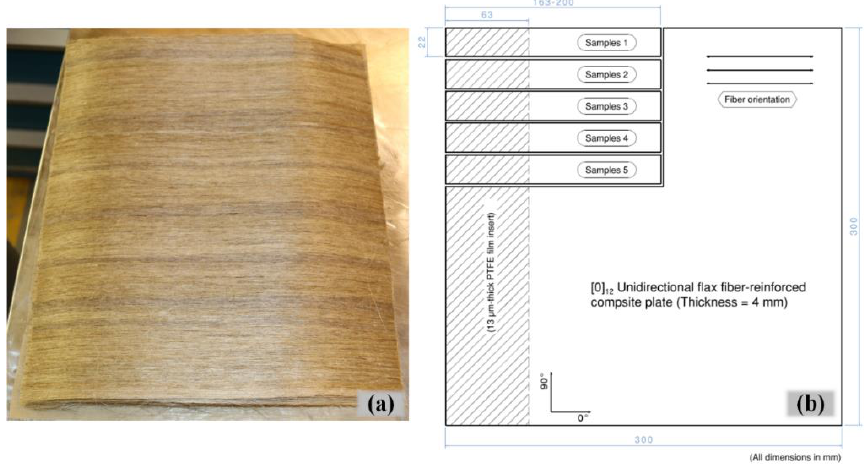
Figure 2. ( a ) Unidirectional flax fiber preform and ( b ) configuration of flax/epoxy pre-cracked laminate.